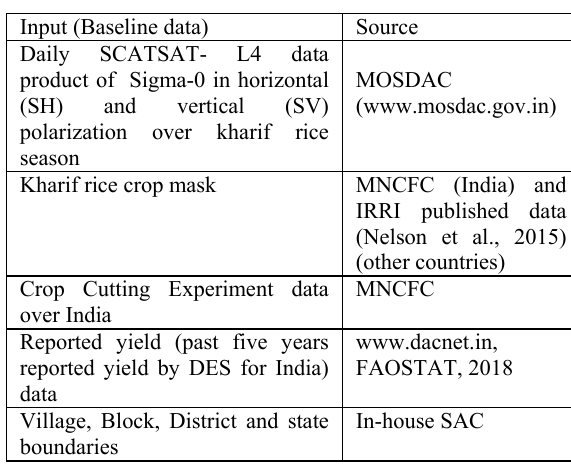
Table 1: Data used for the analysis of rice growth phase and for developing rice grain yield